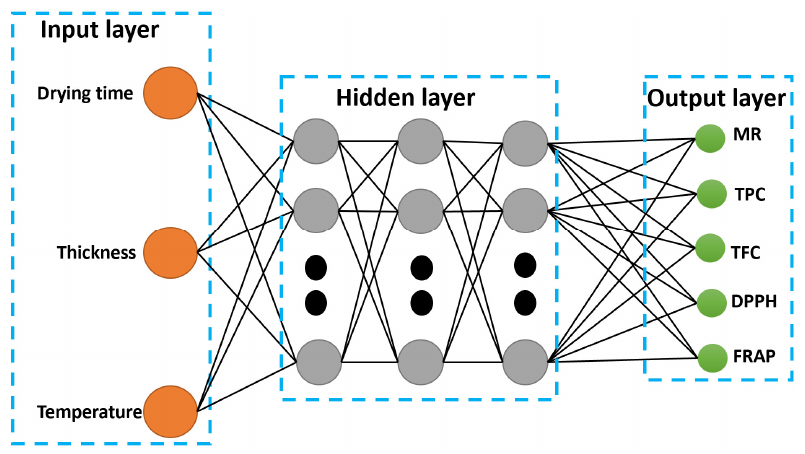
Figure 2. Artificial neural network topology applied for this study.